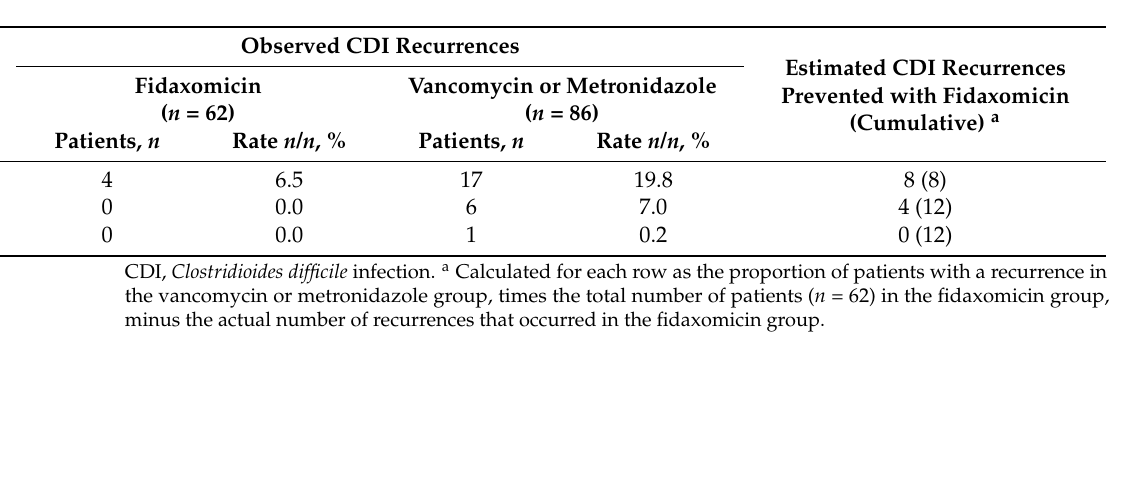
Table 2. Estimated CDI recurrences prevented with fidaxomicin compared with vancomycin or